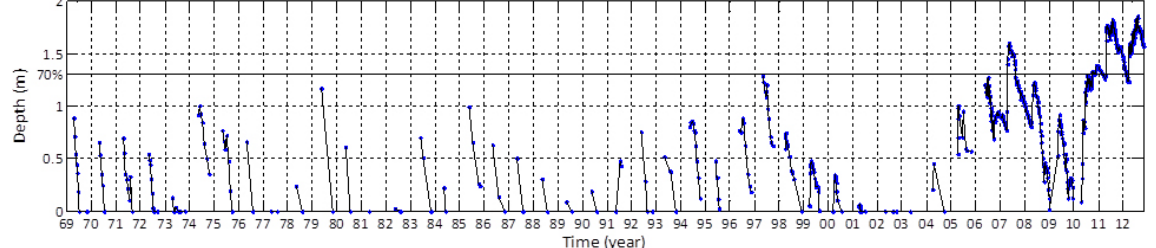
Fig. 4. Pond 109 water depths from 1969 to